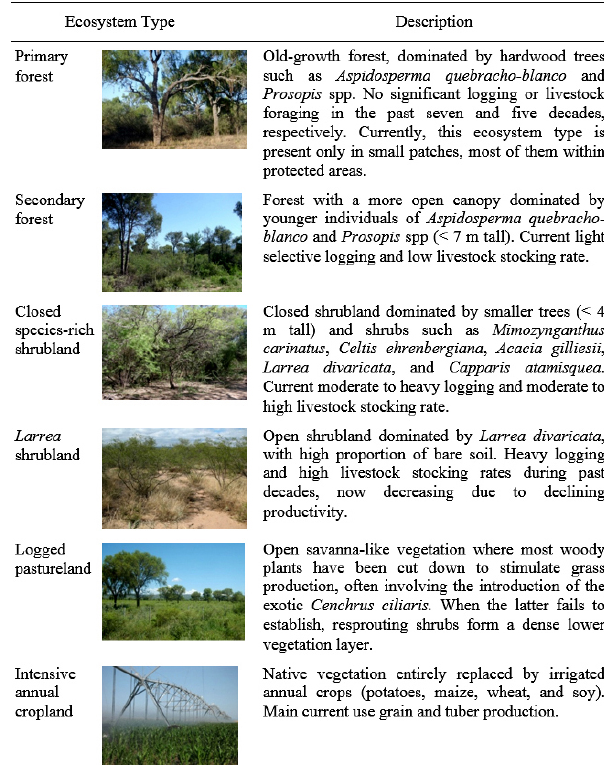
Fig. 2 . Main characteristics of six major ecosystem types observed in Western Córdoba, Argentina. For more detailed ecological description see Conti and Díaz